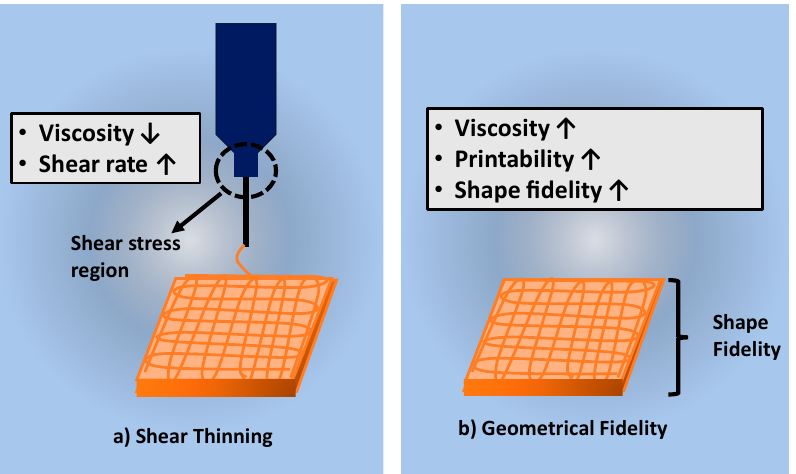
Figure 5. Shows the factors affected the printing process ( a ) shear thinning and ( b ) geometrical fidelity of bioscaffold.